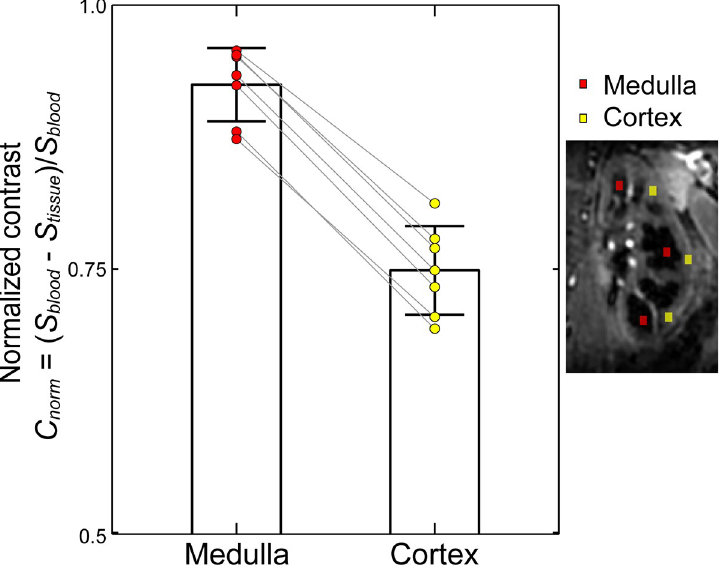
Fig 8. Image contrast between renal tissues (cortex and medulla) and arterial blood. Renal arteries are seen with strong contrasts relative to background renal tissues (right image). Normalized contrast, C norm = ( S blood − S tissue )/ S blood , was calculated by setting 3 regions of interests (ROIs) in each of left and right kidneys; representative locations of the ROIs in the left kidney are shown for cortex (yellow) and medulla (red). The normalized contrast was 0.75 ± 0.04 and 0.92 ± 0.03 for cortex and medulla, respectively. Colored points represent the values for individual subjects ( N = 7). The reference arterial blood signal, S blood , was obtained from a ROI located in the aorta where renal arteries bifurcate.